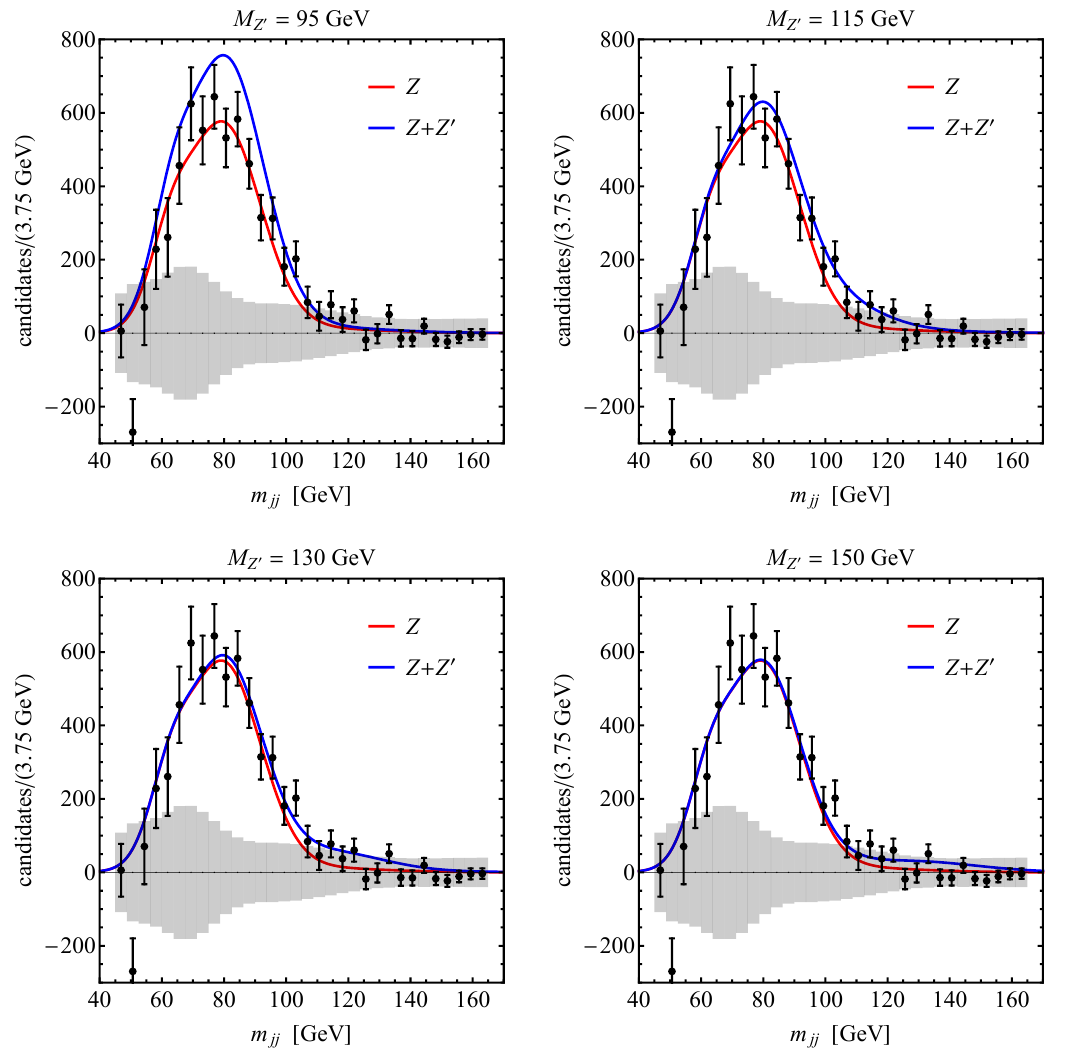
Figure 10 . Dijet mass distributions in Z ! b (cid:22) b predicted in the U(1) D model for di(cid:11)erent Z 0 masses (blue curves). All predictions employ the benchmark parameters (5.6). The background- subtracted dijet mass distribution as measured by LHCb in [17] (black error bars), the Z ! b (cid:22) b mass model within the SM (red curves) and the one standard deviation total uncertainty band (grey bands) is also shown. The uncertainty band includes statistical and systematic uncertainties. See text for further